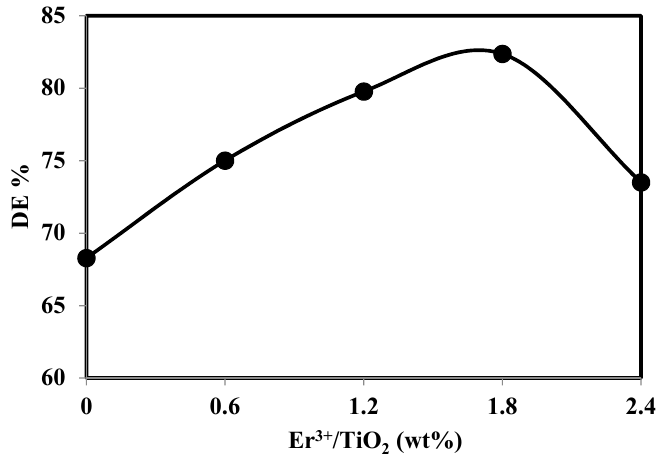
Catalysts 2016 , 6 , 163 Figure 11. DE% of chloroxylenol using different wt % of Er 3+ /TiO 2 . Figure 11. DE% of chloroxylenol using different wt % of Er 3+ /TiO 2 .